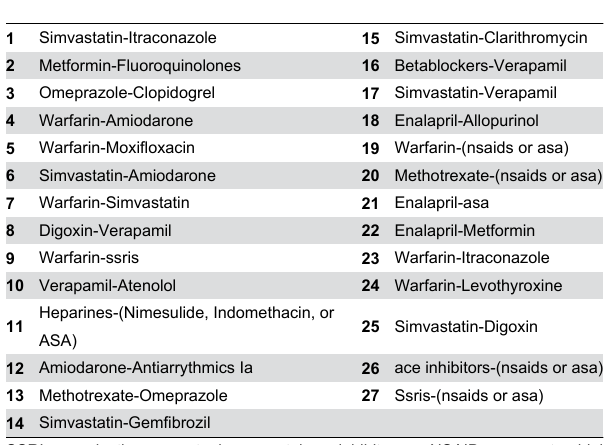
Table 1. List of the 27